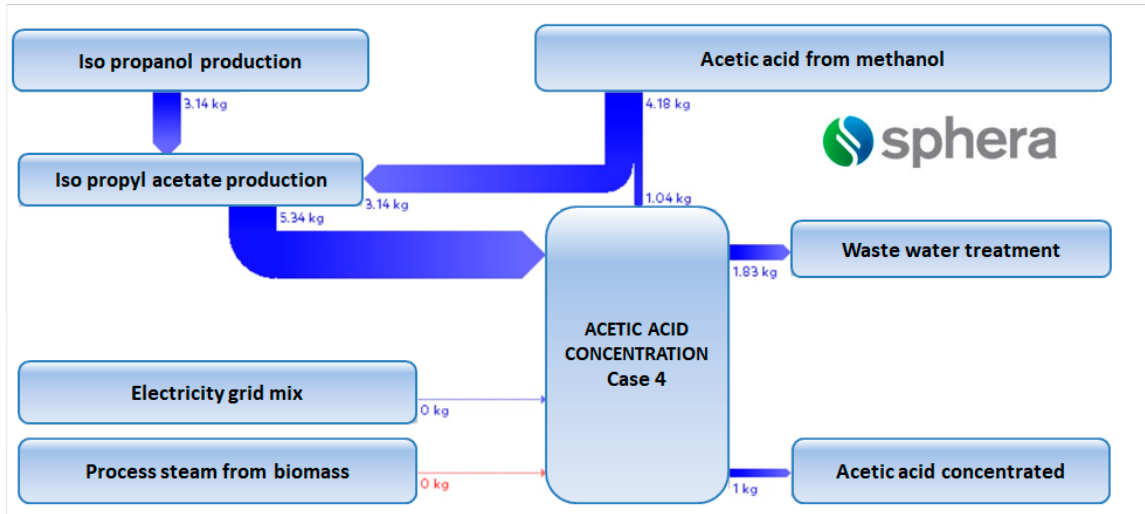
Figure 7. GaBi diagram for case 4.5.